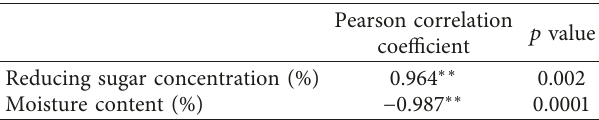
Table 4: Correlation coefficient of reducing sugar and moisture content with acrylamide formation.